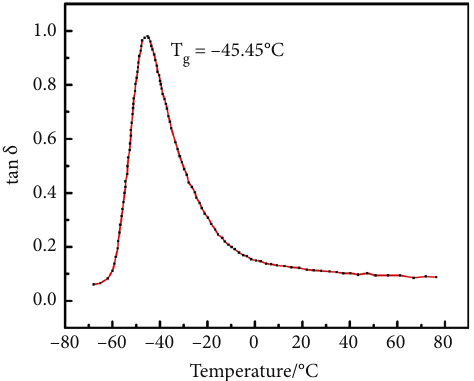
Figure 2: Curve of tangent of loss angle changing with temperature. Figure 3: Curve of horizontal shift-factors α T changing with